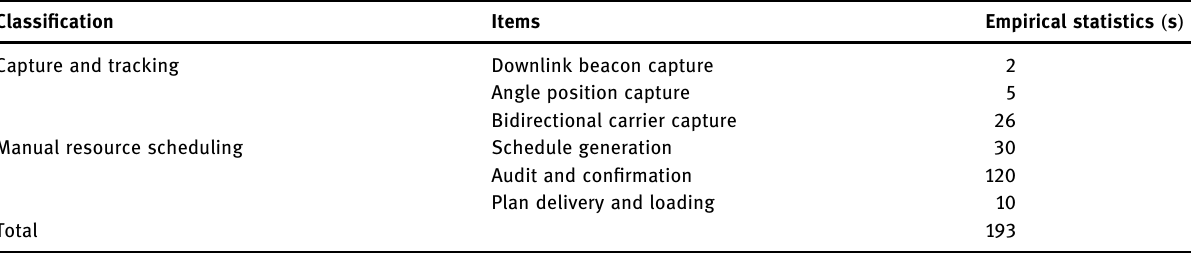
Table 5: Statistics of additional schedule time for planned access mode Classi fi cation